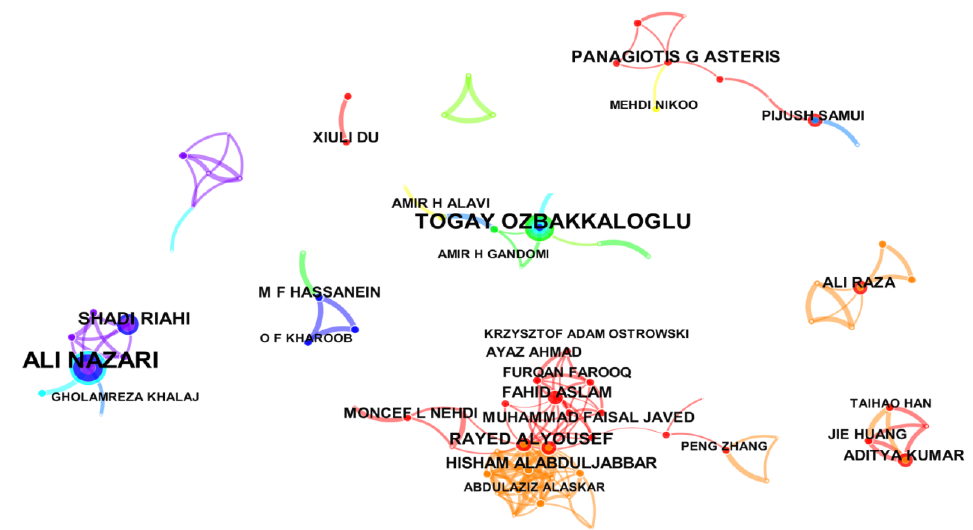
Figure 4. Research Author Collaboration Network.